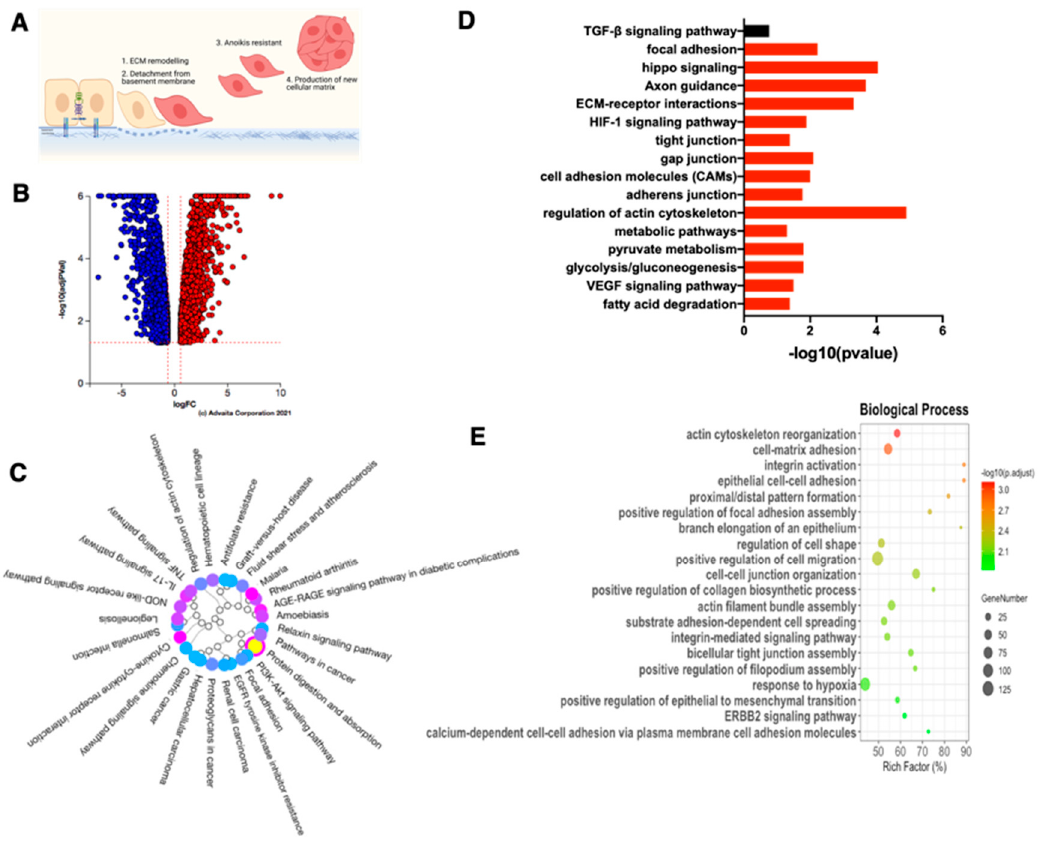
Figure 4. RNA-sequencing analysis of the mesenchymal state of the ovarian cancer cell lines. The M state cells of R182, R2615, and OVCAR3 were compared to their respective E state cells in this analysis. ( A ) Proposed scheme of the completed steps in E differentiation to the M state include (1) ECM remodeling; (2) detachment from the basement membrane; (3) anoikis resistance; and (4) the production of new cellular matrix. ( B ) Volcano plot of differentially expressed genes (DEGs); blue dots represent downregulated DEGs, red dots represent upregulated DEGs. ( C ) Dendrogram of significant biological pathways in M compared to E cells. ( D ) Bar plot of the EMT-related biological pathways in M compared to E cells. Significant pathways are presented as red bars, and non-significant pathways as black bars. ( E ) Top 20 of GO terms for the analysis of the biological processes in M when compared to E